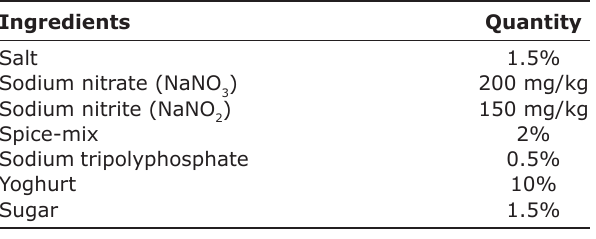
Table-1: Formulation for marination of pork chunks.